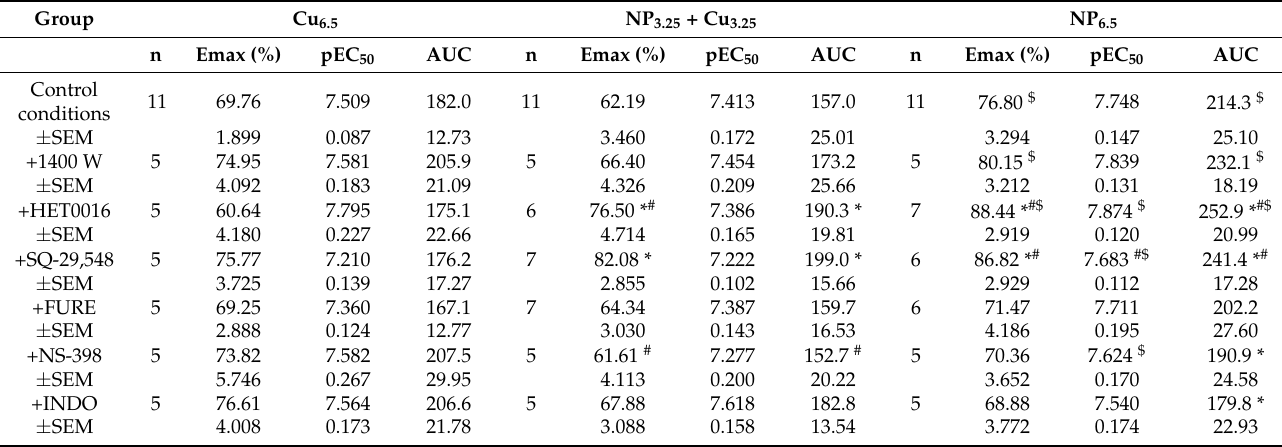
Figure 3. The relaxant response to acetylcholine in the isolated thoracic rings from rats supple- mented with Cu 6.5 , NP 3.25 + Cu 3.25 , and NP 6.5 . Results are means ± SEM, * compared to Cu 6.5 , # com- pared to NP 3.25 + Cu 3.25 , p < 0.05 of n = 11 rats; ANOVA/Tukey’s. The red curve is the nonlinear re- gression model (log agonist vs. response). A significant change in the relaxant response was ob- served between the NP 3.25 + Cu 3.25 and NP 6.5 groups of rats.